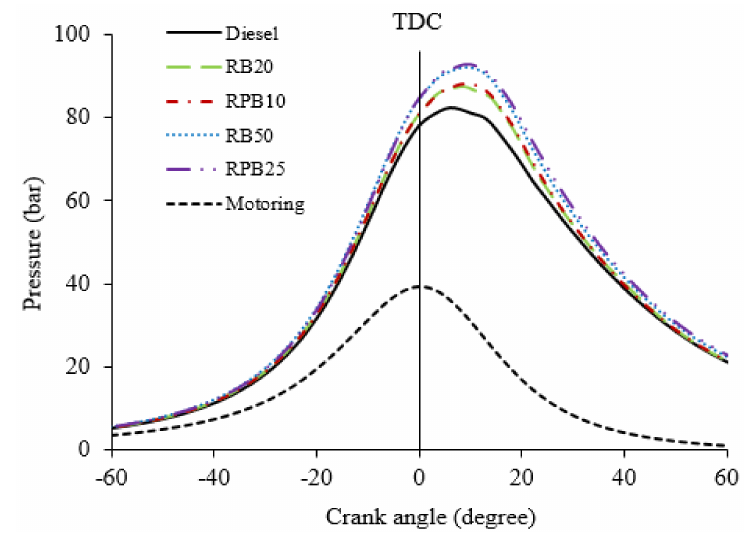
Figure 4. Variation of cylinder pressure at 2000 rpm at full load.